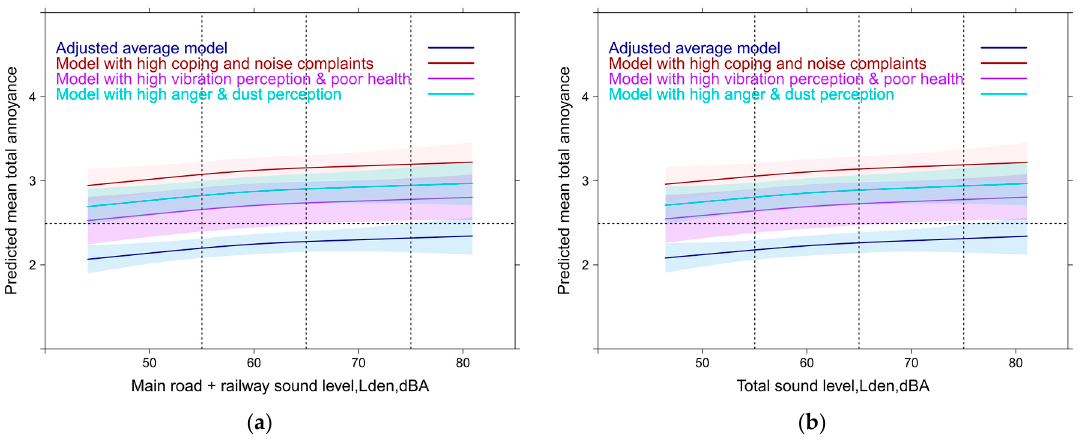
Figure 16. Predicted mean total annoyance associated with main road-railway source combinations ( a ) Horizontal line = mean total annoyance. Adjusted for age, sex, education, noise sensitivity, health status, complaints about air pollution at the community level + the respective other factors in the specific model; ( b ) Predicted mean total annoyance associated with the total sound level combination (same adjustments).